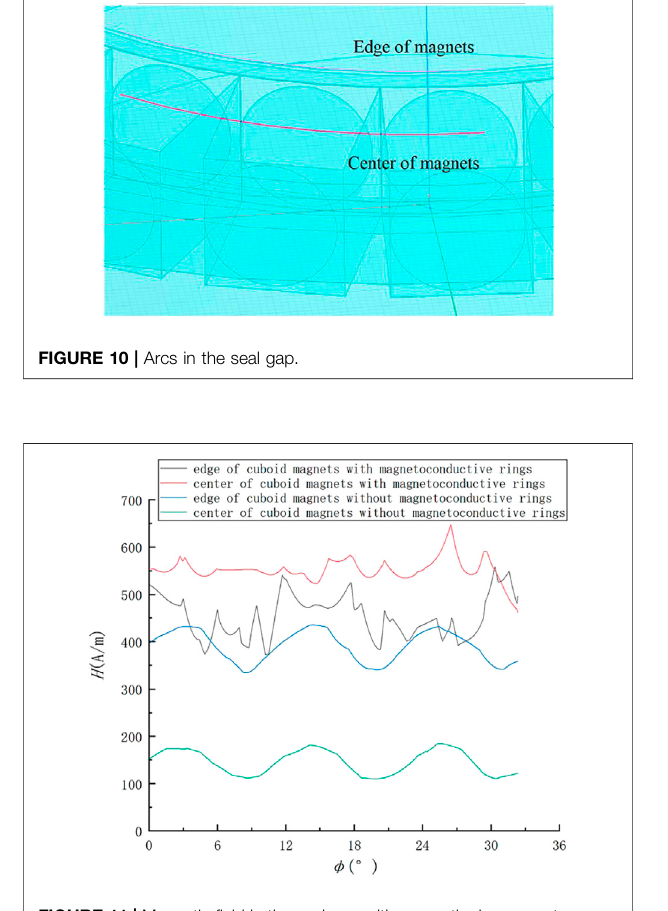
FIGURE 11 | Magnetic fi eld in the seal gap with magnetic rings or not.